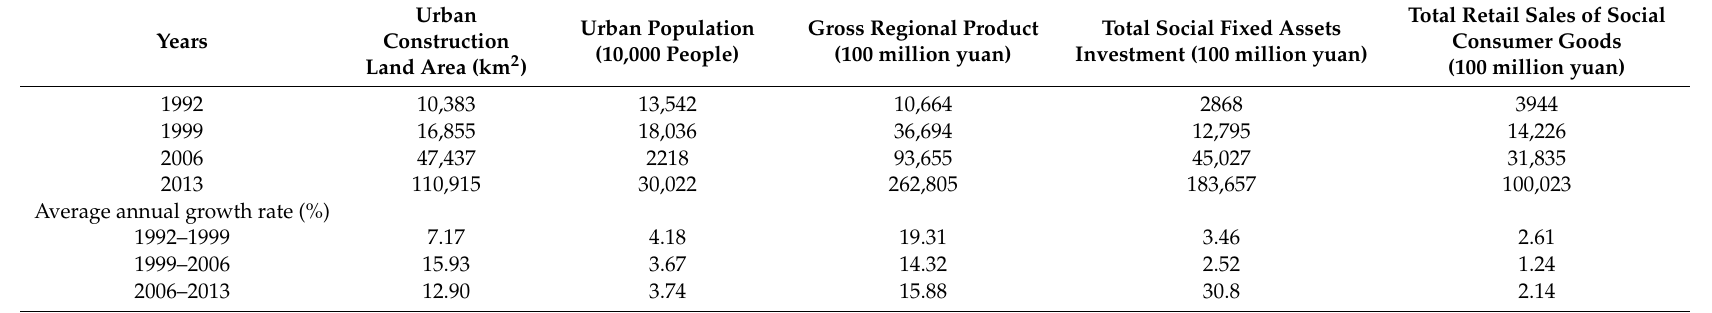
Table 6. The statistical value and average annual growth rate of the four driving factors of urban built-up area expansion in the